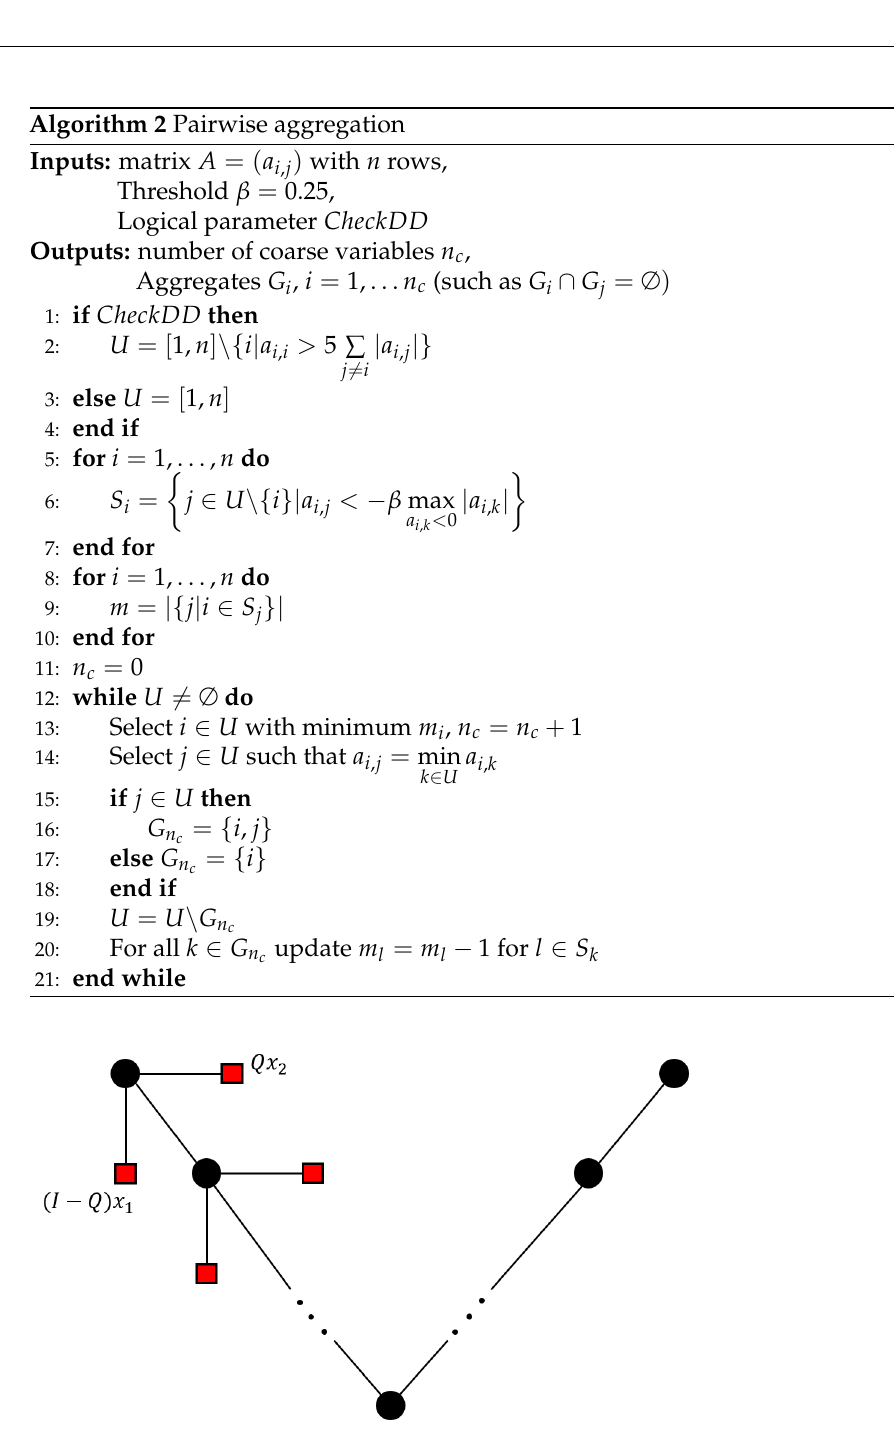
Figure 1. A V-cycle of aggregation multigrid in conjunction with deflation. Algorithm 3 depicts the procedure of using a multigrid as preconditioner for a